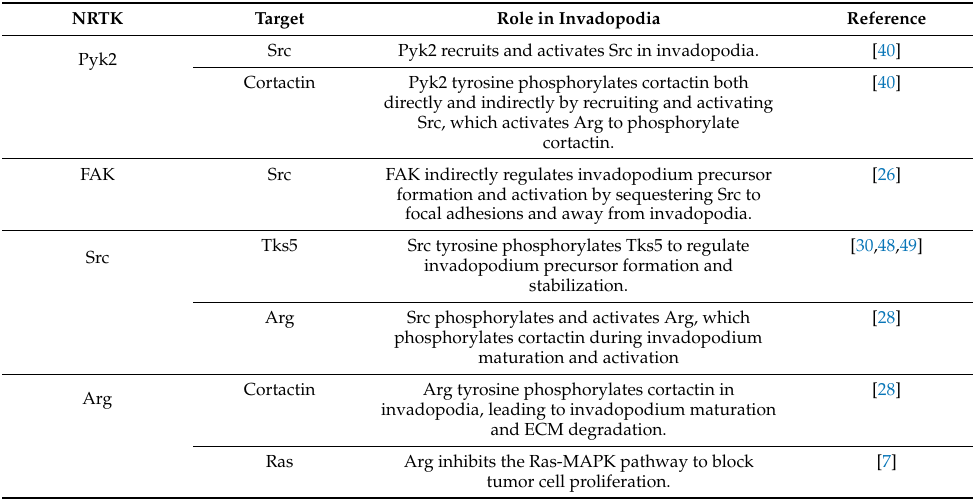
Table 1. Major NRTKs and their targets in the Pyk2-Src-Arg-cortactin invadopodial